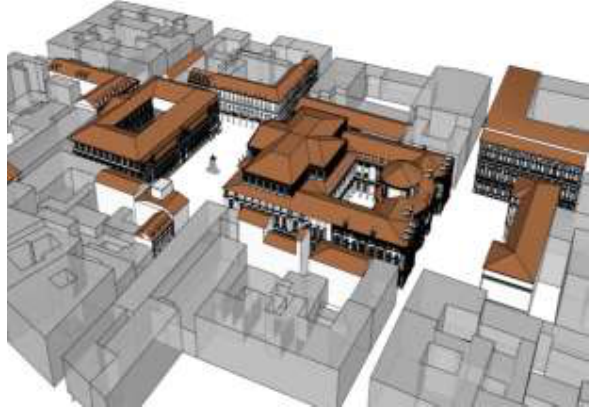
Figure 10. 3D Model of the context around the National Parliament by Alesandro Antonelli and Palazzo Carignano by Guarino Guarini. F. Giusti, I. Giai Via, A. Quarati, 2014.